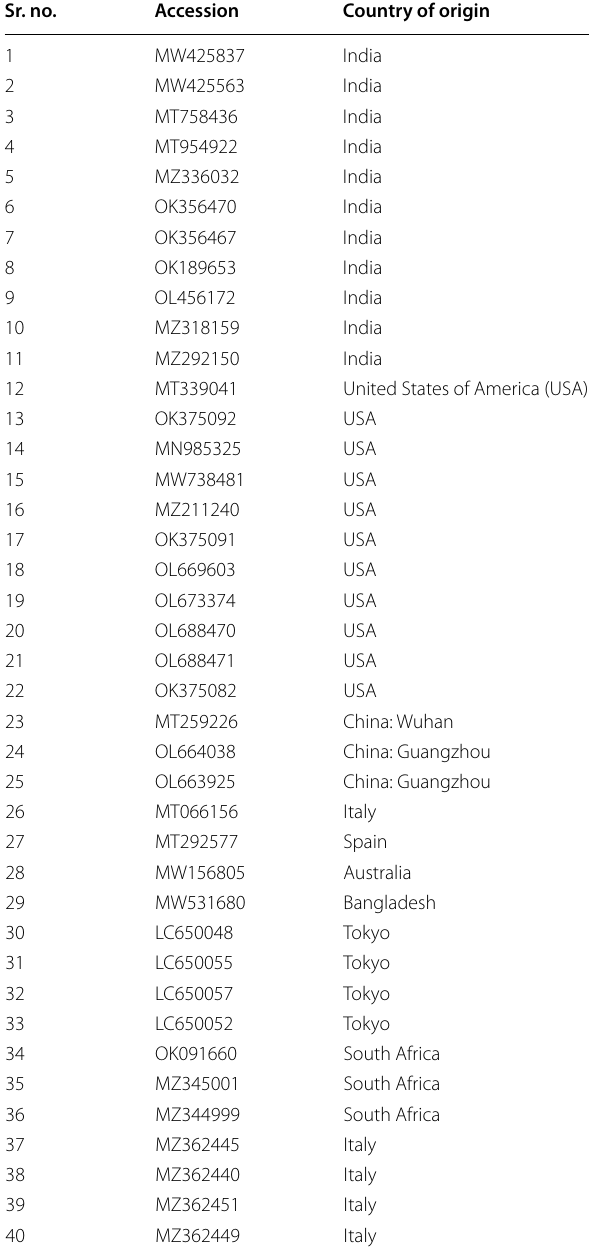
Table 1 List of accession numbers of the sequences and their country of origin retrieved from nucleotide database of NCBI for the design of siRNAs Sr.